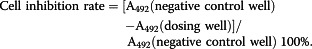
Synthesis of 1,2,4-triazole Schiff bases 6.